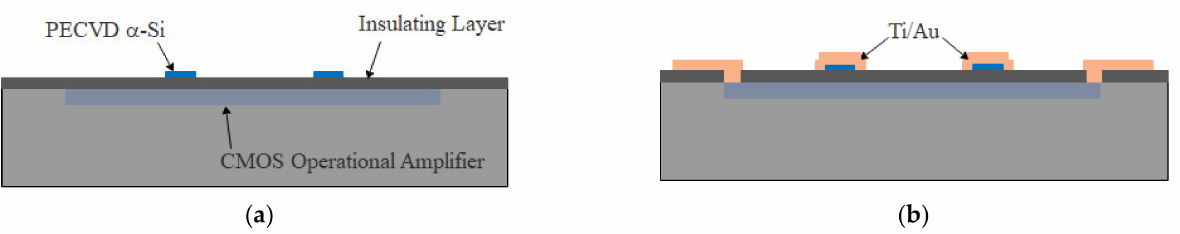
Figure 6. Redistribution flow of the readout circuit chip. ( a ) After composite layers of SiO 2 /SiN x /SiO 2 were deposited by PECVD to serve as insulating layers for redistribution, a layer of amorphous silicon was deposited and patterned for subsequent Au–Si eutectic bonding; ( b ) the contact holes were patterned on the insulating layer, and composite metal layers of Ti/Au were sputtered and patterned for redistributing the operational amplifiers to serve as the instrumentation